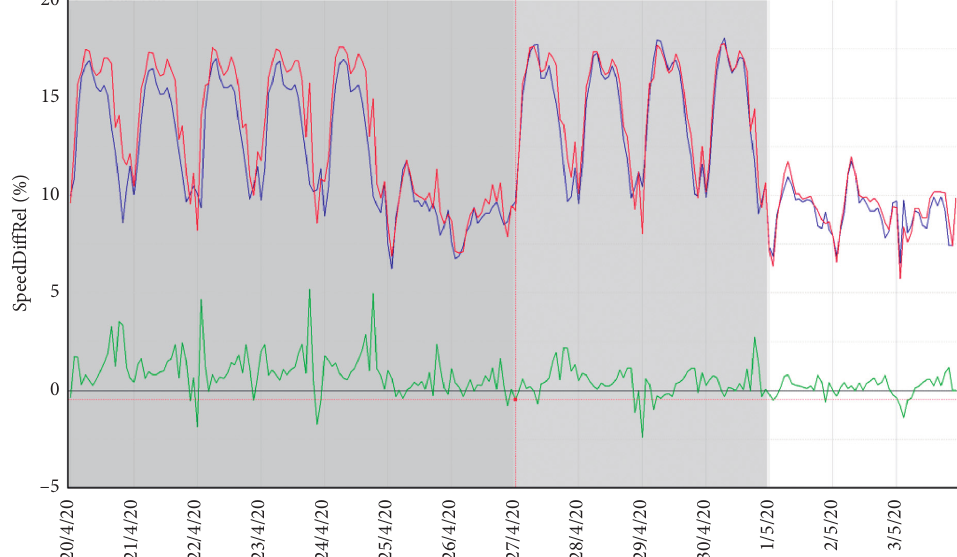
Figure 12: Two-week period from 20 April to 3 May 2020. SpeedDiffRel in percentage points by hours.